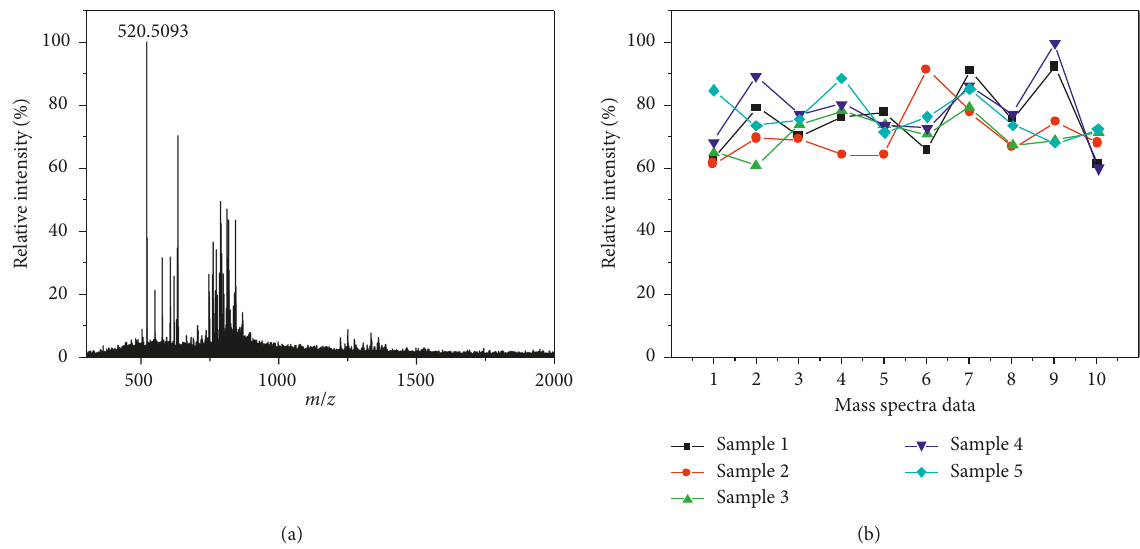
Figure 3: (a) Typical mass spectrum of porcine liver tissue, and (b) ion intensity of m / z 520.5093 in 50 mass spectra from 5 pieces of the liver.